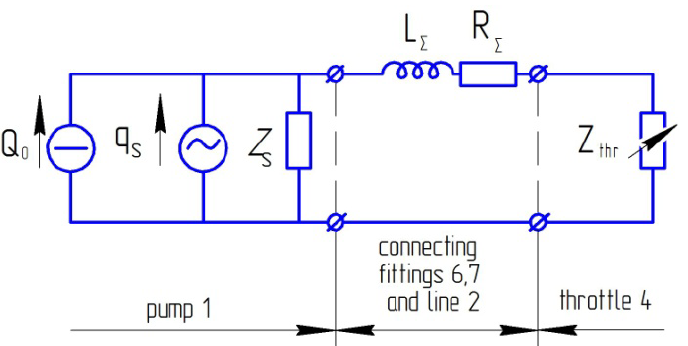
Figure 15. Calculated hydrodynamic model of the bench system implementing an inertial load. R Σ , L Σ —active resistance and “inertia” of the pipeline, respectively.